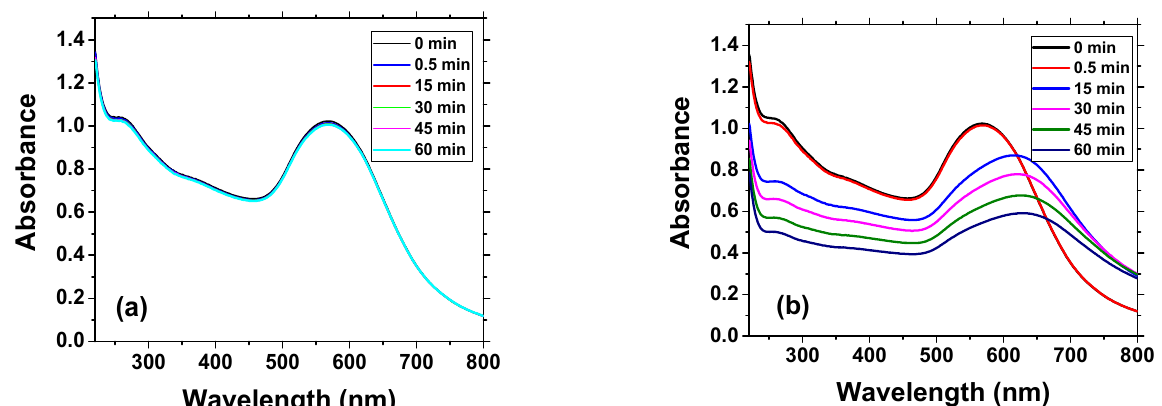
Figure 4. Changes of absorbance spectra of the suspension of AuNPs modified by β -casein and MCH in time for ( a ) 0.1 nM chymotrypsin and ( b ) 10 nM chymotrypsin.